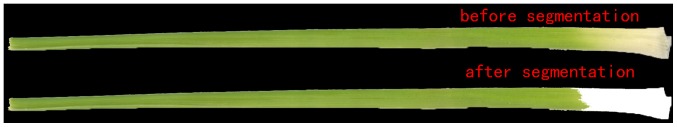
The segmentation of the rice sheath image.